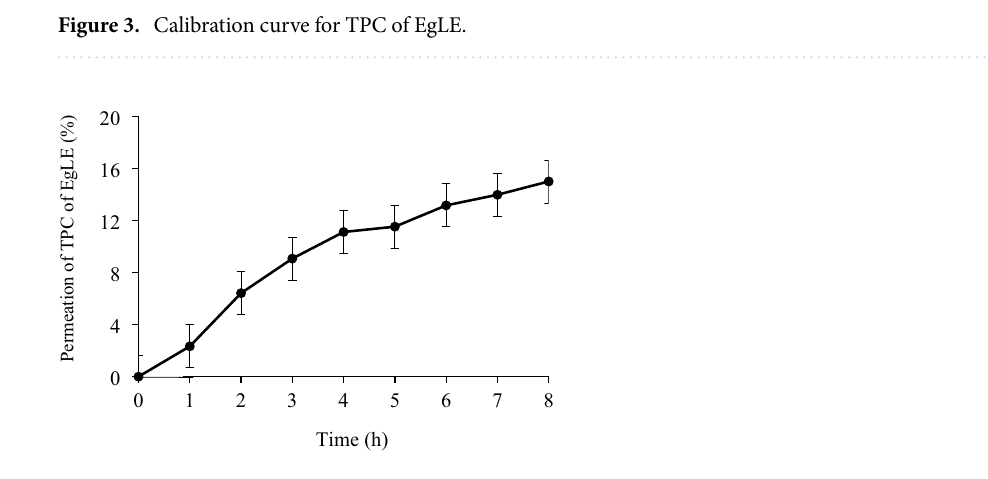
Figure 4. Percentage of the TPC of EgLE permeated from the optimal nanoemulsion after 8